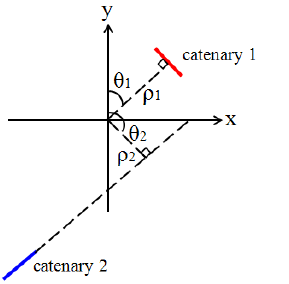
Figure 3. Catenary positions with θ and ρ